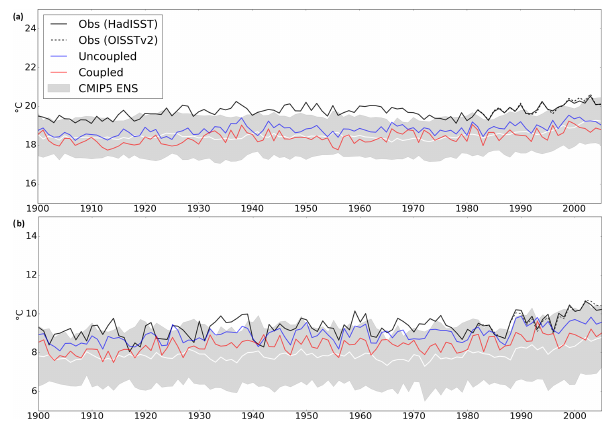
Figure 4. Sea surface temperature annual means over the marginal seas in our 20th century coupled simulation (CCLM-NEMO) be- tween 1900 and 2005 compared to observations (HadISST and OIS- STv2), to the atmosphere-only CCLM simulation (with SSTs pre- scribed by the driving MPI-ESM nudged to observations), and an ensemble mean (white line) and spread (shaded area) from CMIP5 simulations. (a) Mediterranean Sea and (b) Baltic and North